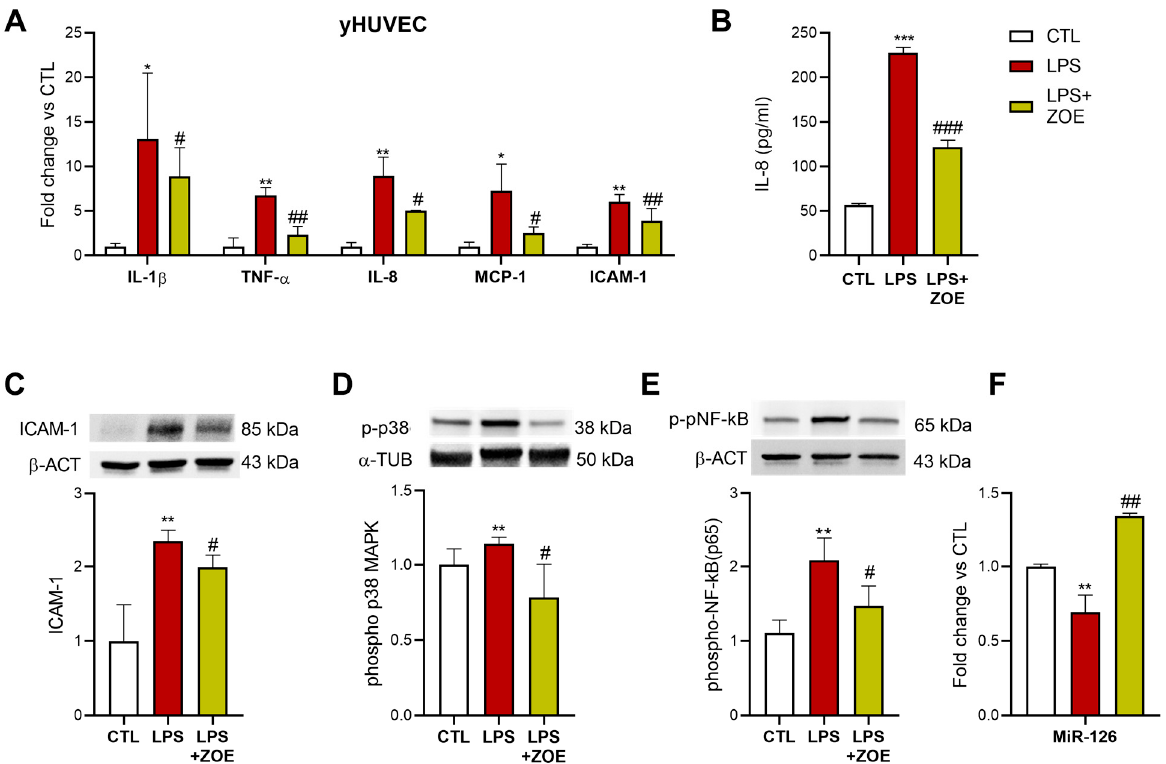
Figure 4. Effect of ZOE on yHUVEC stimulated with LPS. Relative mRNA expression of IL-1 β , TNF- α , MCP-1, IL-8, and ICAM-1 ( A ), concentration (pg/mL) of IL-8 in the culture medium ( B ), representative western blot analysis showing ICAM-1 ( C ), p-p38 MAPK ( D ) and p-NF-kB ( E ) expression and expression levels of miR-126 ( F ) in yHUVEC. β -actin and α -tubulin were used as a control. The bands were quantified by ImageJ. All data are reported as fold change vs. untreated yHUVEC. The results are expressed as mean ± SD from three independent biological replicates. Asterisks (*) indicate significance versus CTL; (#) indicates significance versus yHUVEC + LPS; one symbol, p < 0.05; two symbols, p < 0.01; three symbols, p < 0.001.